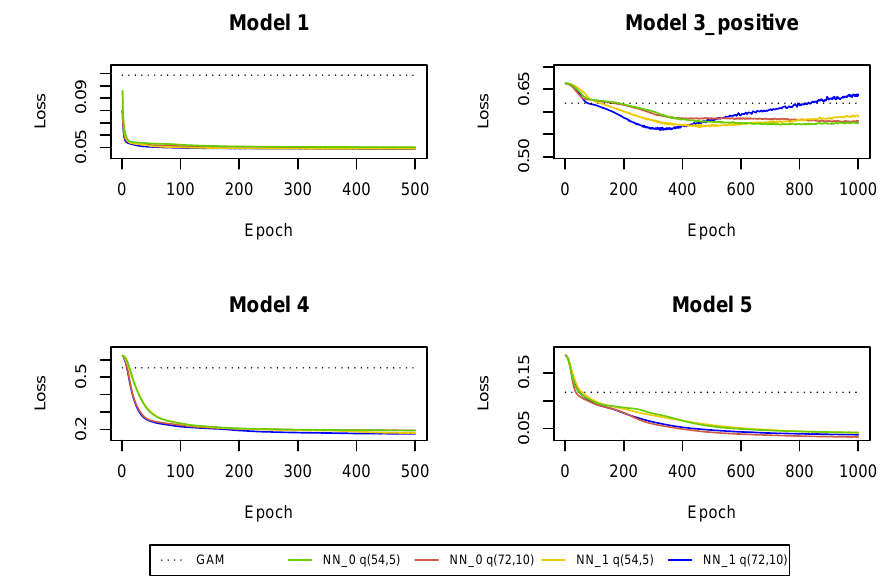
Figure A7. Cross-entropy and deviance loss functions on validation sets observed during the training of the neural networks in k =